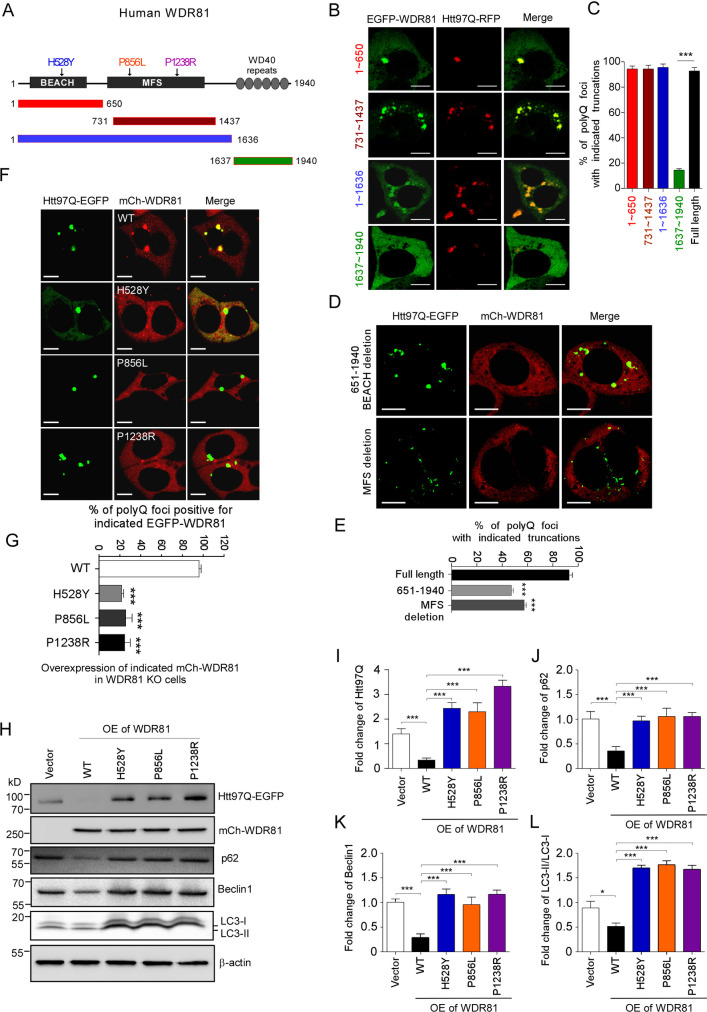
The BEACH and MFS domains are sufficient for WDR81 recruitment onto Htt97Q aggregates.(A) Schematic representations of full-length and truncations of human WDR81 protein analyzed in present study. Indicated mutations of WDR81 are shown in the BEACH and MFS domains. (B and C) Recruitment of indicated truncations of EGFP-WDR81 onto Htt97Q-RFP aggregates (left panel). Plasmids of Htt97Q-RFP and EGFP-WDR81 were co-transfected into HeLa cells at the same time. 48 h later, recruitment of indicated proteins was observed by fluorescent microscopy. Quantification of the percentage of polyQ foci positive for indicated EGFP-WDR81 truncations is shown in the right panel (C). 200 cells were analyzed for the recruitment in each group. (D and E) Recruitment of mCh-WDR81 without BEACH domain (651–1940) or mCh-WDR81 without MFS domain onto Htt97Q-EGFP aggregates (upper panel). Plasmids of Htt97Q-EGFP and mCh-WDR81 were co-transfected into HeLa cells at the same time. 48 h later, recruitment of indicated proteins was observed by fluorescent microscopy. Quantification of the percentage of polyQ foci positive for indicated mCh-WDR81 truncations is shown in the bottom panel (E). 215 cells were analyzed for the recruitment in each group. (F and G) Colocalization of Htt97Q-EGFP foci with wild-type (WT) or mutant mCherry-WDR81 (mCh-WDR81). Quantification of the percentage of polyQ foci positive for indicated WT or mutant mCh-WDR81 is shown in the bottom panel (G). 210 cells were analyzed for the recruitment in each group. (H-L) Immunoblotting analysis of Htt97Q-EGFP and autophagic proteins without or with overexpression of WT or mutant mCh-WDR81 in WDR81 KO HeLa cells. Fold changes of Htt97Q-EGFP (I) and autophagic proteins (J-L) were normalized to control (vector). Scale bars represent 10 μm in all panels. For quantifications, means±SEM were derived from three independent experiments and analyzed using t-tests or ANOVA. ** P <0.01. ***P <0.001.